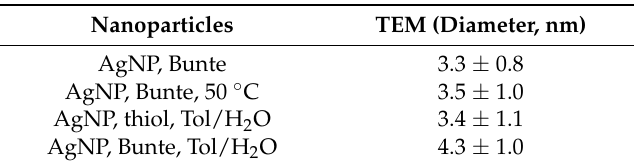
Table 2. Average core size of Ag nanoparticles. The ligand/silver molar ratio used for the synthesis is 1:1. Reproduced from Ref. [56],